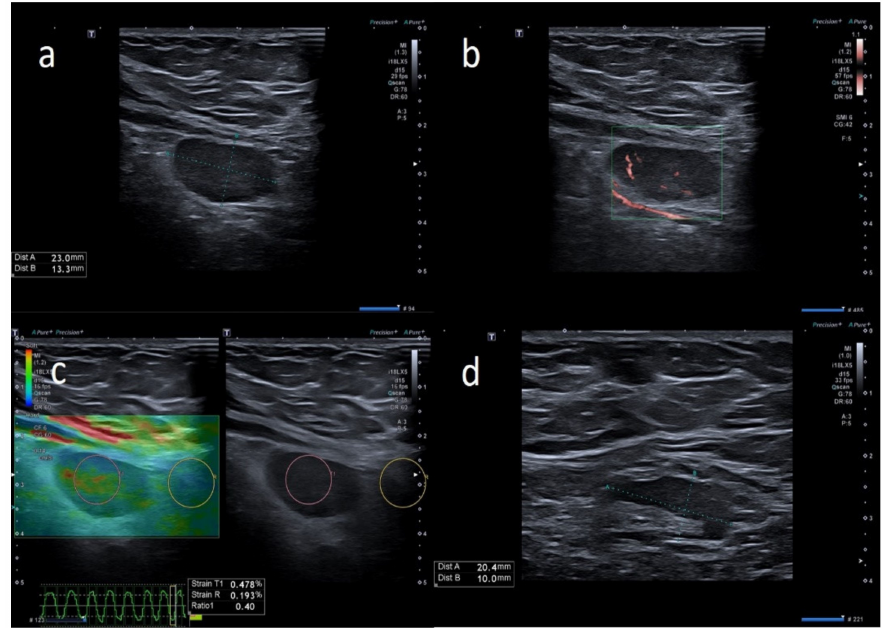
Figure 4. 49-year-old female with unilateral left axillary adenopathy noted 6 days after receiving the first dose of the Pfizer-BioNTech COVID-19 vaccine in her left deltoid muscle. ( a ) B-mode sonogram image shows ovular, hypoechoic lymph node with hilum absence. ( b ) SMI images show central and peripheral vascularization. ( c ) Elastosonography strain shows similar pattern of the node compared to surrounding tissue. ( d ) After 1 month, the cortical thickening appears uniform, with hilum